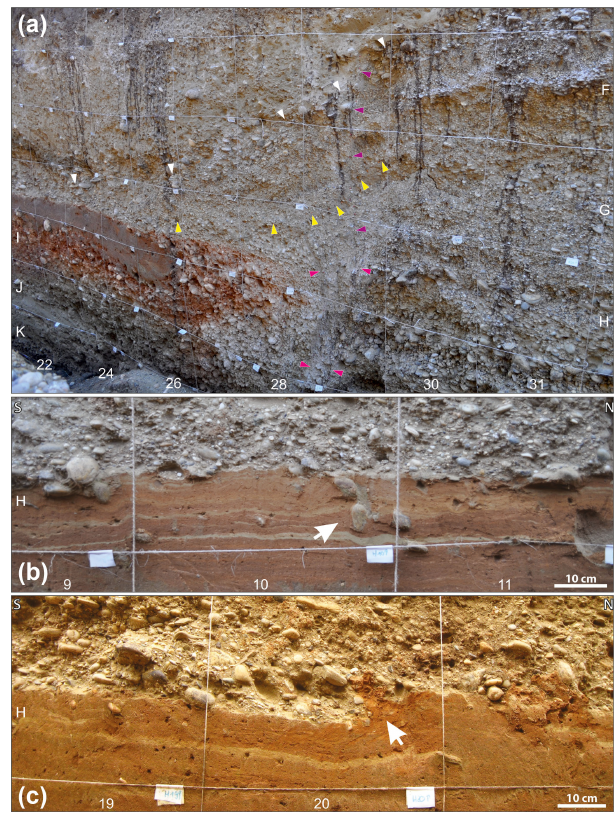
Figure 8. Details from the W-facing wall of the trench SDF3. (a) Wedge associated with earthquake B2 (top: white arrows; base: yellow arrows; see text for discussion) overlying an upward widen- ing fault (red arrows), recognized from pebbles, which are oriented parallel to the fault. The top of the wedge (white arrows) is offset by a narrow deformation band that emerges from the fault below the wedge (purple arrows). Offset occurred during B1. (b, c) Lam- inated flood sediments (clay, silt, and fine sand) underlying collu- vium of wedge B2. Pebbles sunken into the soft sediment (b) and flame structures protruding into the overlying gravel (c) are indica- tive for